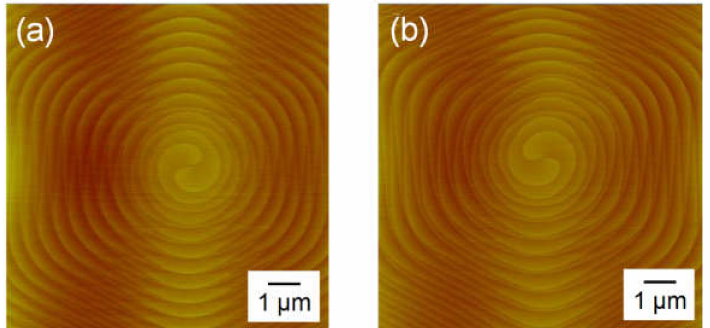
Figure 11. Atomic force microscopy (AFM) images of the spiral hillocks on the on-axis 4H-SiC epitaxial layers grown for ( a ) 30 min and ( b ) 5 h at the growth rate and ramp-up time of 40 µ m / h and 60 min, respectively.